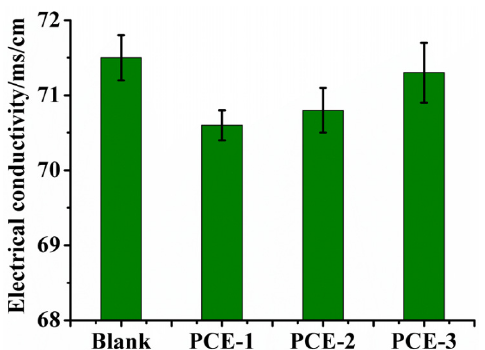
Figure 6. Electrical conductivity of the CaCl 2 solution with mass concentration of 5% mixed with PCEs.